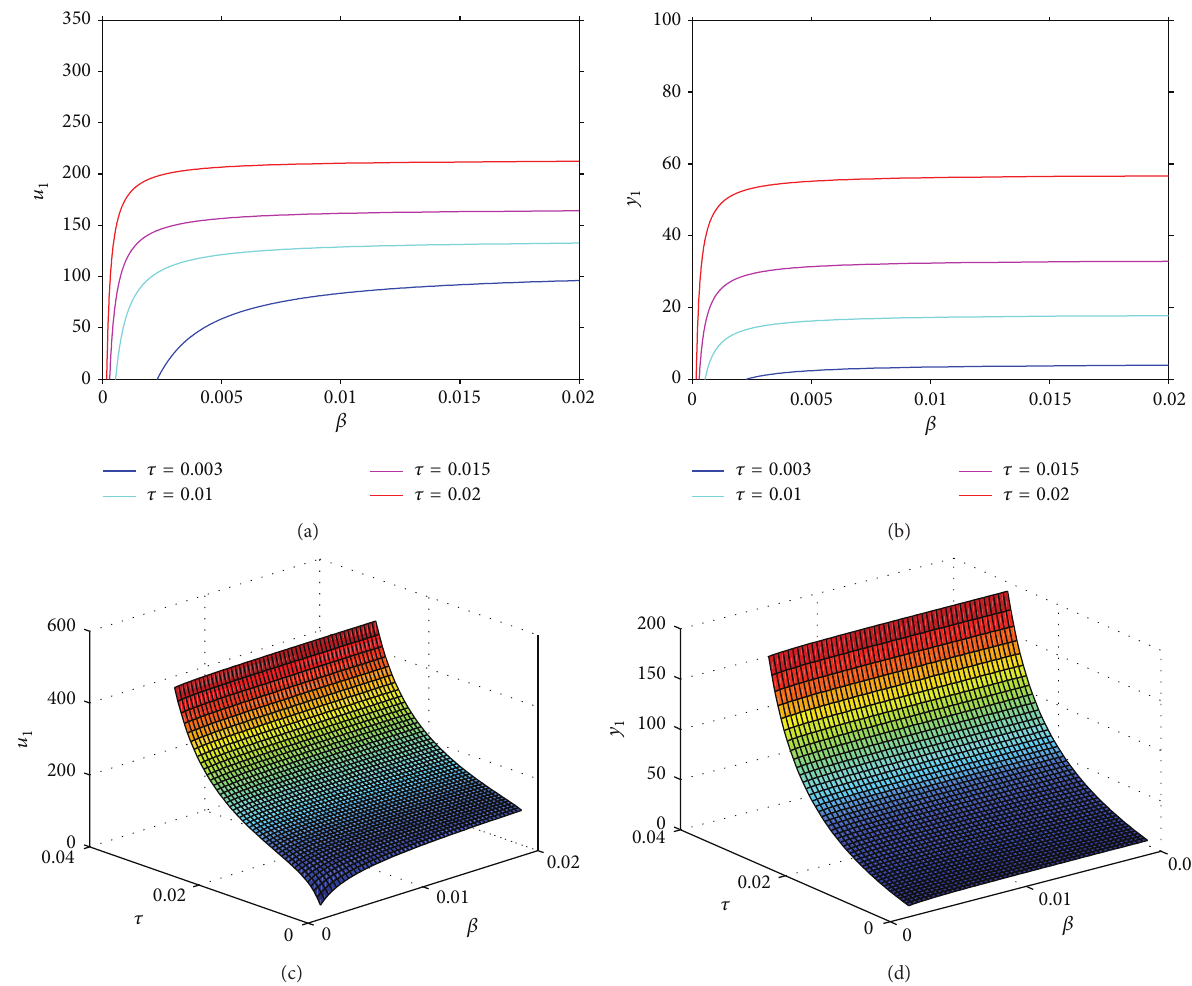
Figure 5: The impact of 𝛽 and 𝜏 on the magnitude of the chronic infection equilibrium 𝑃 1